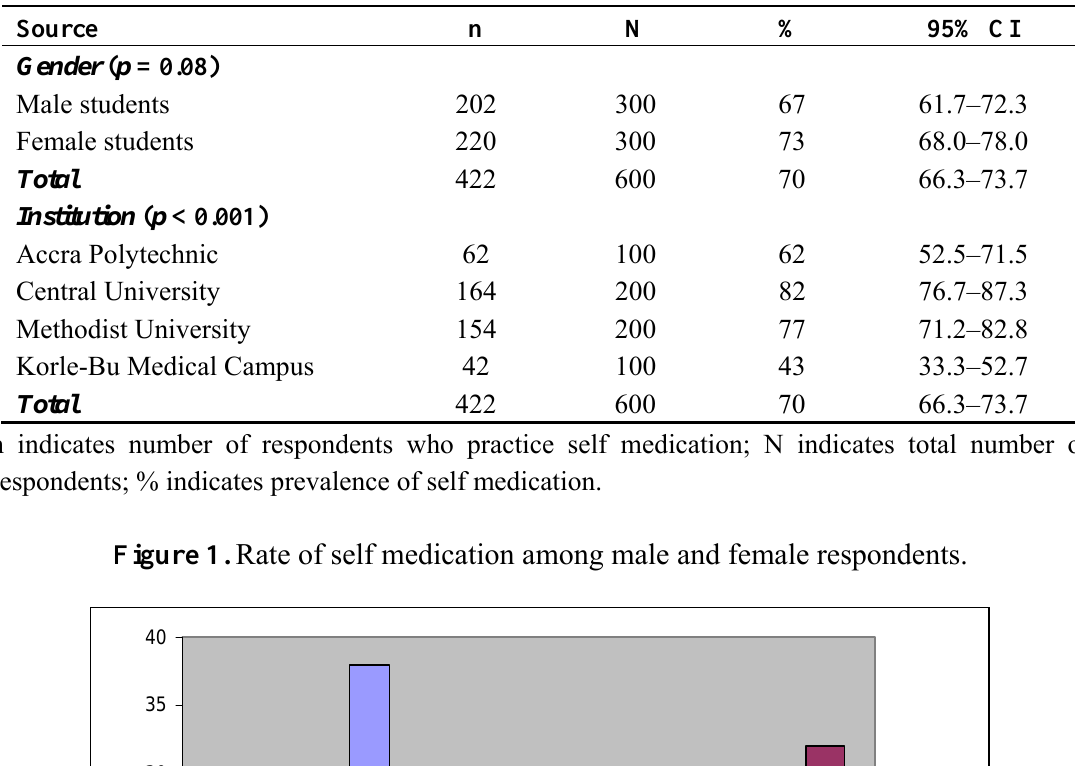
Table 2. Prevalence of self medication.